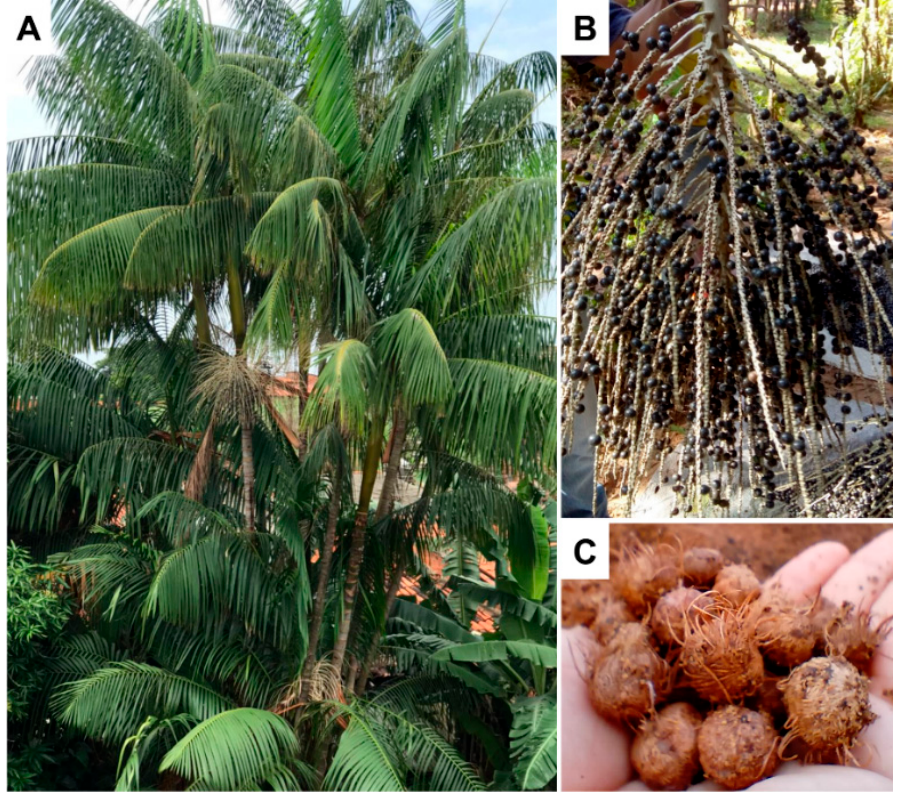
Figure 1. Euterpe oleracea tree ( A ), fruits ( B ) and seeds ( C ). Different parts of E. oleracea have been studied for chemical composition and phar- macological properties [10]. The oil extracted from the pulp or seed of the fruit presents mainly fatty acids, whose oleic acid (47.58%), palmitic (24.06%) and linoleic (13.58%) acids are the major compounds, while palmitoleic, vaccenic, lauric and stearic acids were minor constituents [11]. High concentrations of (+)-catechin and procyanidin oligomers have also been found in E. oleracea pulp and oil extracts [12].